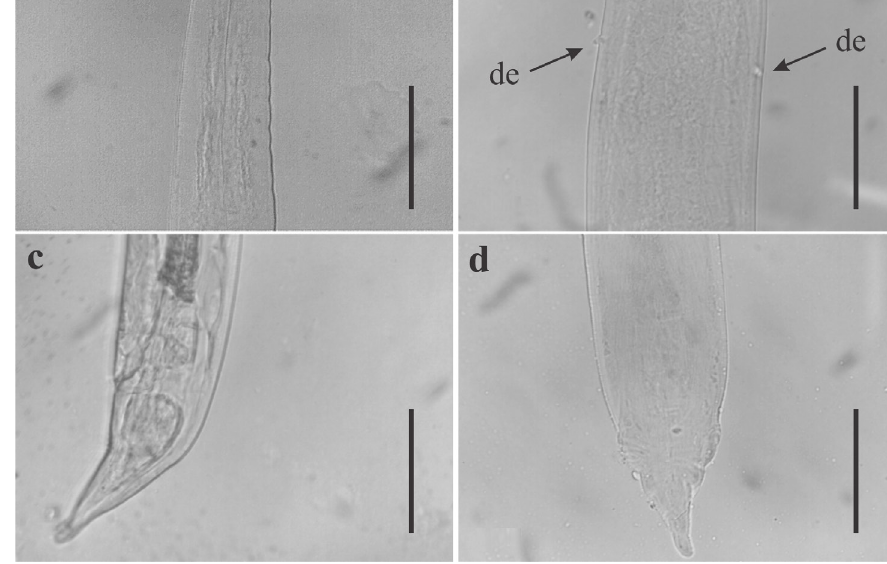
Figure 3. Line drawing of the Spiroxys sp. (larvae stage). (a) whole mount, ventral view; (b) cephalic end, lateral view; (c) tail, lateral view. Abbreviations: ep = excretory pore; de = deirids; am = amphid; ps = pseudolabia. Scale bars: a = 0.5 mm; b and c = 0.1 mm.